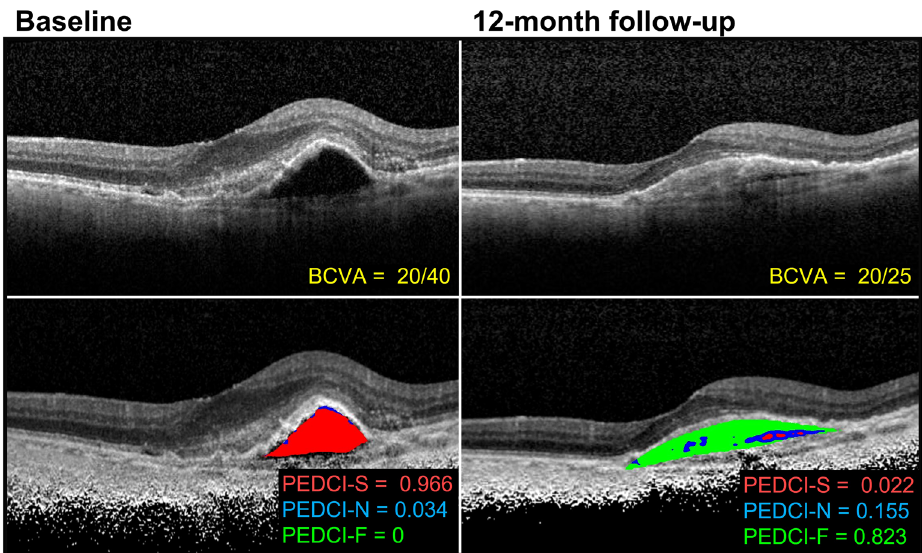
Figure 6. Optical coherence tomography images from a patient with neovascular age-related macular degeneration at baseline and 12-month follow-up. Baseline images are treatment naïve. The patient received six intravitreal aflibercept injections before the 12-month visit. Best-corrected visual acuities (BCVA) are reported along with calculated PED composition indices: serous (PEDCI-S), neovascular (PEDCI-N), and fibrous (PEDCI-F). Classified areas include serous (red), neovascular (blue), and fibrous (green) components of the